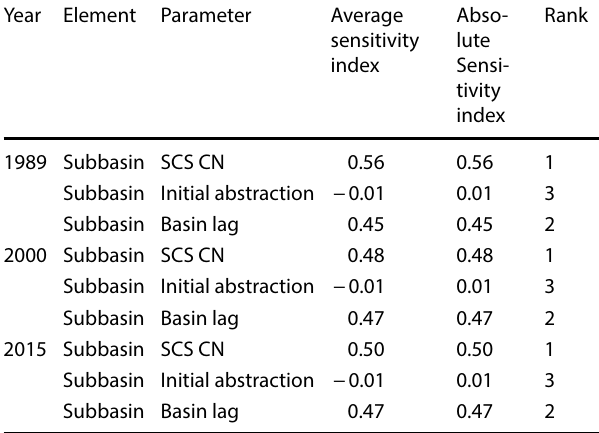
Table 9 Parameter sensitivity analysis and parameter sensitivity ranking